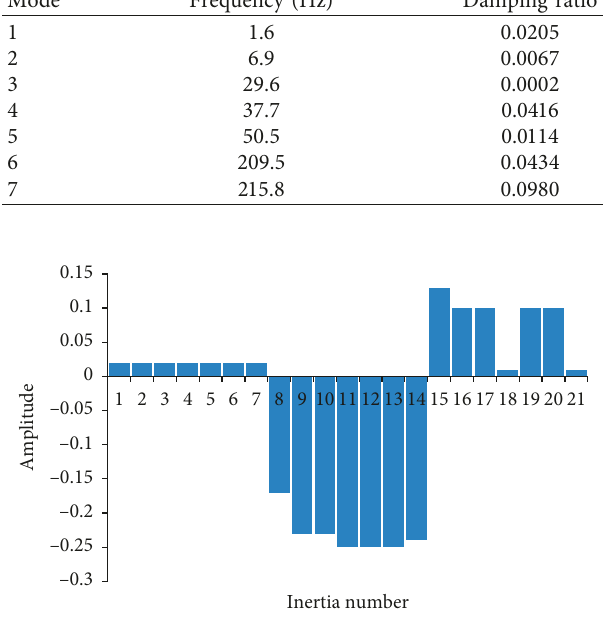
Figure 17: The 5 th torsional vibration modal shape of the minivan